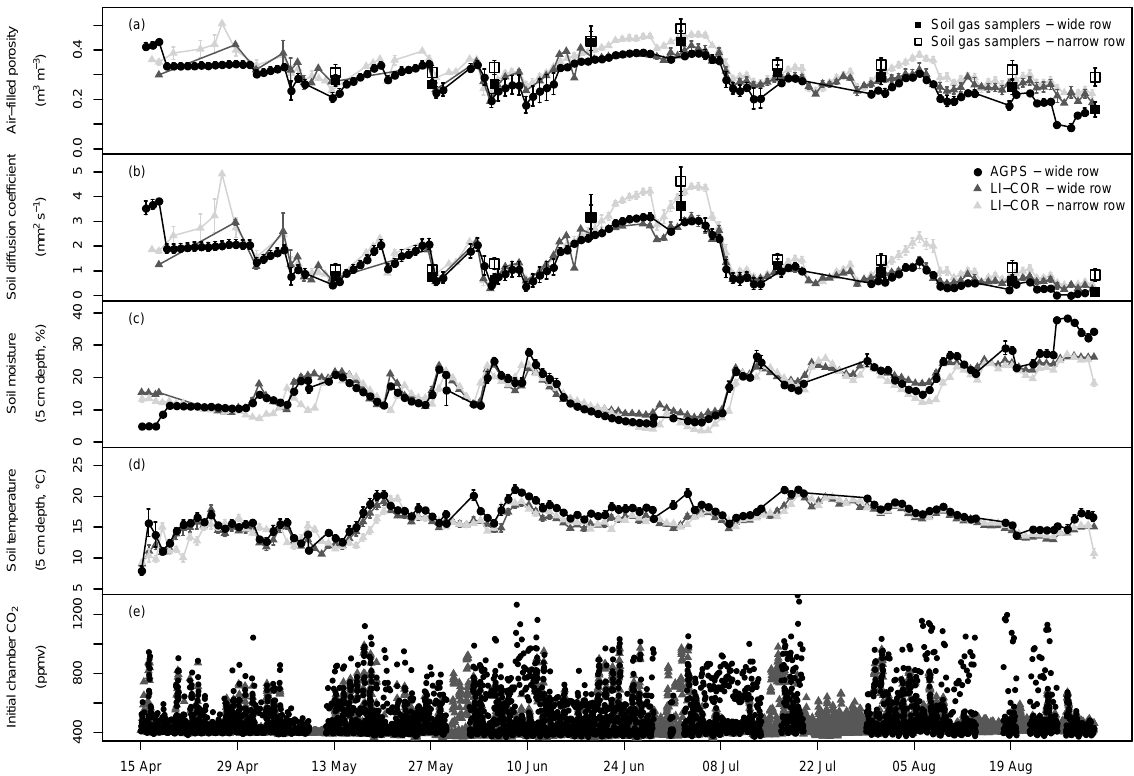
Figure 2. Comparison of different environmental variables measured by the AGPS and the LI-8100A before each chamber closure. Pan- els (a–d) show daily averages with their respective standard deviations. For air-filled porosity and the soil diffusion coefficient only those measurements have been included for which both soil temperature and moisture data were available from the specific chamber at the time of the measurement. All single measurements are shown for the initial CO 2 concentration (panel e ), which is equivalent to the CO 2 concentra- tion at time = 0s of the flux measurement. They are measured by the AGPS prior to the chamber closure and calculated for the LI-8100A by its internal software.